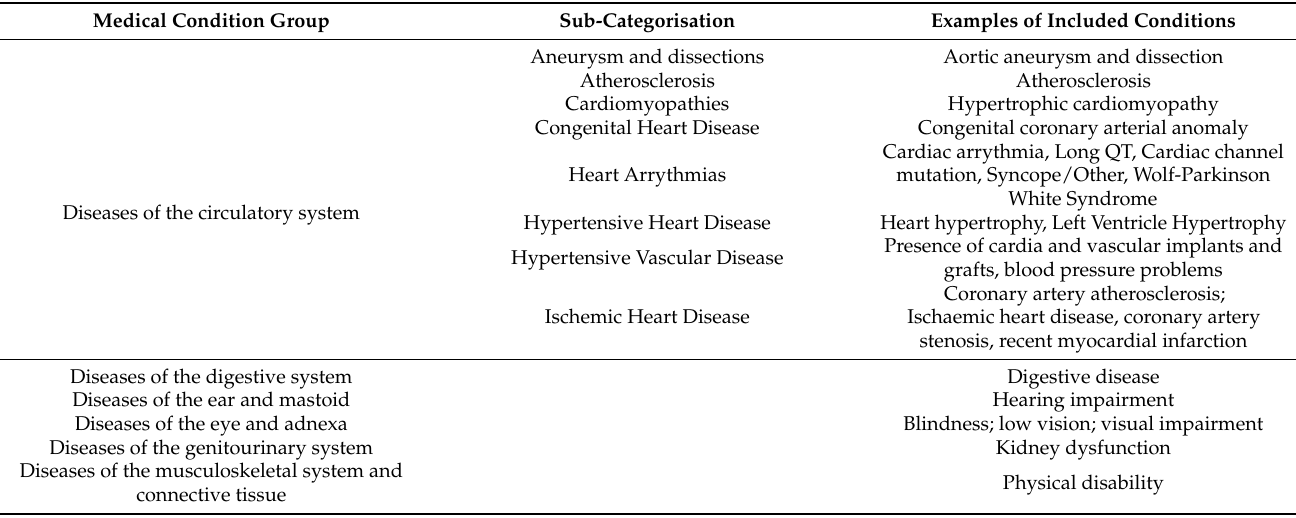
Table 2. Medical condition groupings and examples of included